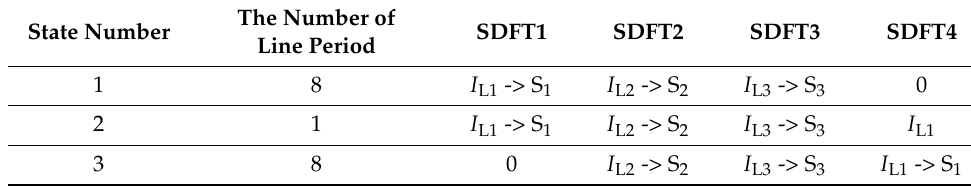
Figure 10. Block diagram of three-phase first harmonic detectors using stable SSDFT. Table 4. The principle of three-phase SSDFT